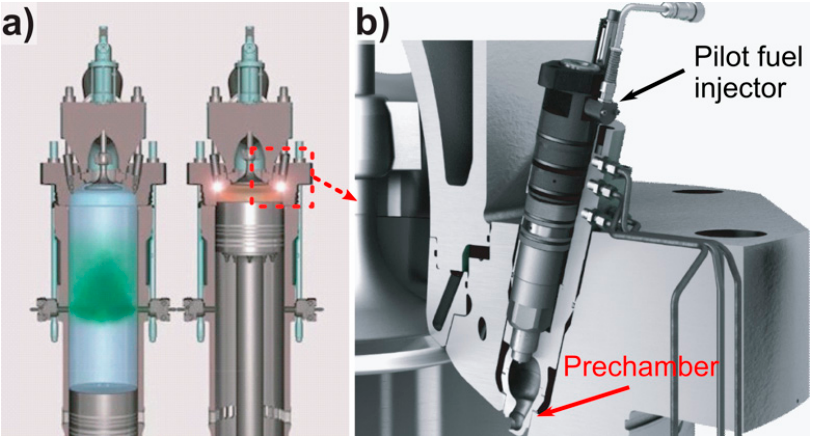
Figure 1. ( a ) The X-dual fuel (X-DF) working principle with gas admission during up-stroke (left) and ignition of the compressed fuel / air mix through the prechamber (right); ( b ) close up of the X-DF pilot injector indicating the position of the prechamber; [7].